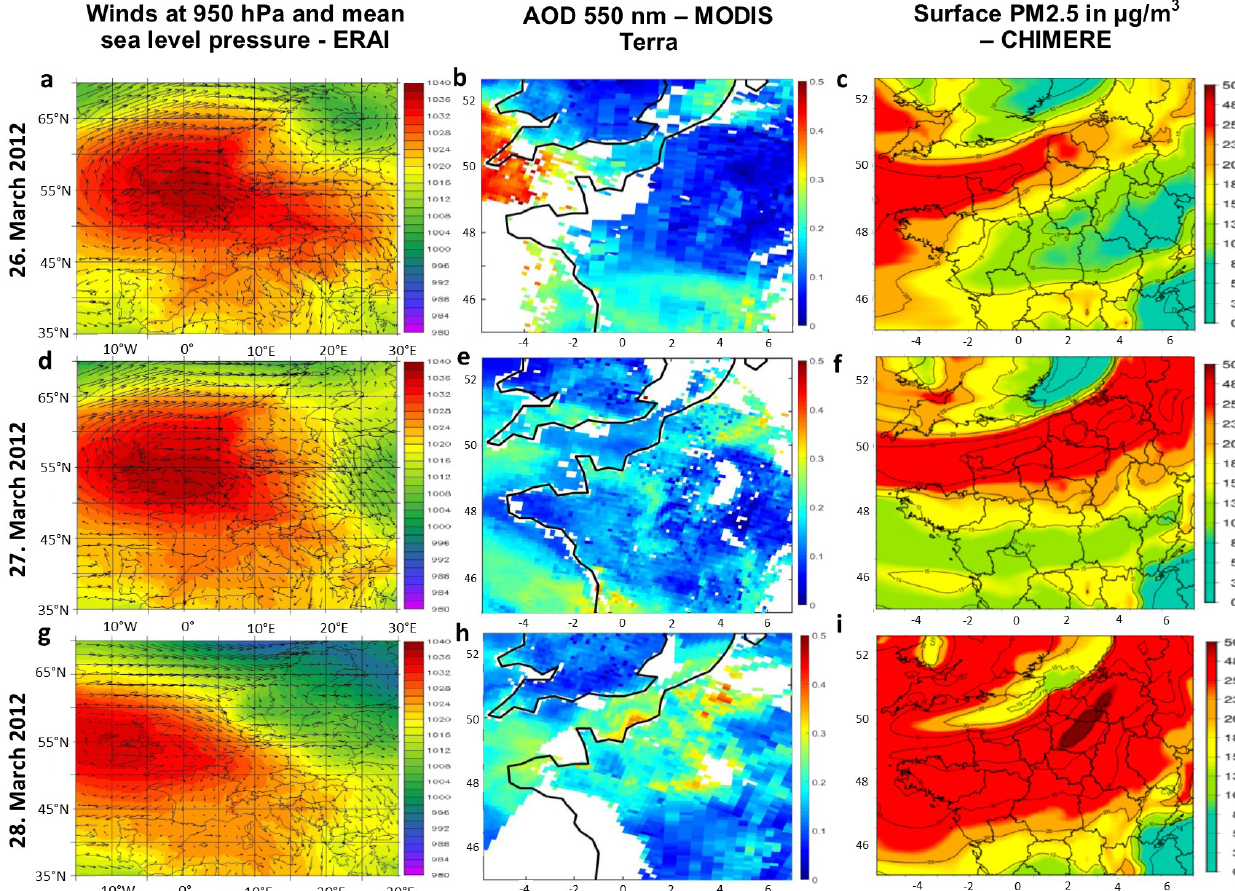
Figure 3. (a, d, g) Meteorological conditions characterized by 950hPa winds (arrows) and sea level pressure (shading) over Europe (15 ◦ W to 20 ◦ E and 40 to 65 ◦ N) from ERAI reanalysis in 26–28 March 2012. Horizontal distribution of particles over northern France ( − 5 to 7 ◦ E and 45 to 52.5 ◦ N) in terms of (b, e, h) AOD at 550nm from MODIS aboard the Terra satellite and (c, f, i) surface PM 2 . 5 (in µgm − 3 ) from the CHIMERE model during the period 26–28 March